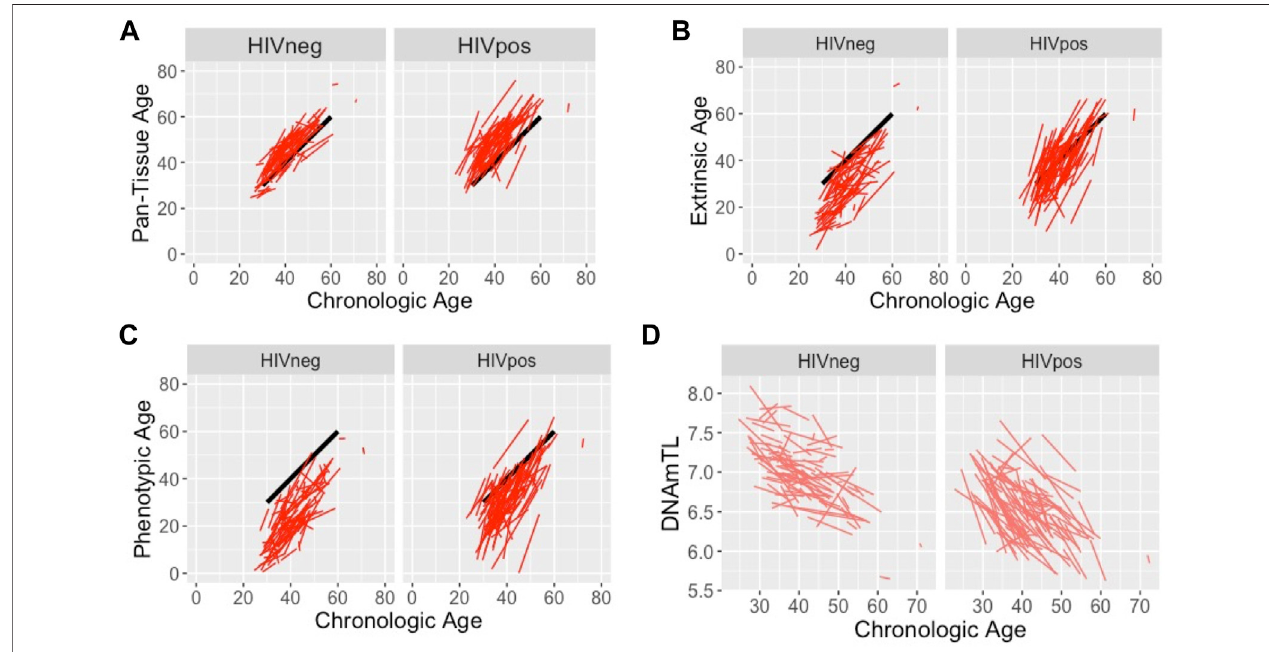
FIGURE 2 | Individual trajectories from Visit 1 to Visit 2 for the Pan-Tissue, Extrinsic, and Phenotypic clocks, and estimated DNAmTL, in HIV-infected (HIVPOS), and uninfected (HIV NEG) men. Trajectories for each participant are plotted with DNAm age (years) or estimated DNAmTL (relative units) on the y-axis, and chronologic age (years) at each visit on the x-axis, for the Pan-Tissue [Panel (A) ], Extrinsic [Panel (B) ], and Phenotypic [Panel (C) ] clocks, and estimated DNAmTL [Panel (D) ]. Heavy black lines are added for reference to indicate a slope of 1 where the rate of epigenetic aging is equal to the rate of change in chronologic age.